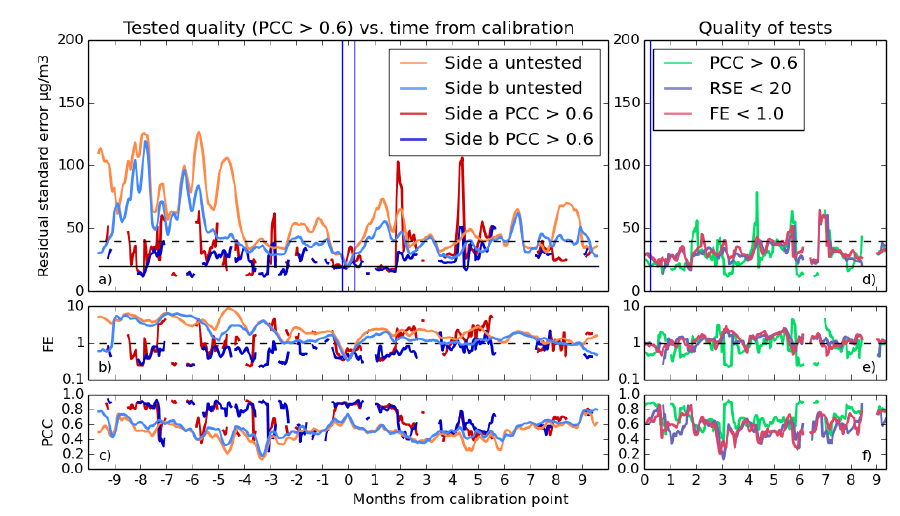
Figure 12. ( a – c ) Comparison between sensor data for NO without goodness testing (light) and with 2 (dark). Both Sensors a and b are plotted. Since fewer fits are used, error due to averaging is higher, and there are both gaps and alarming spikes in the RSE in graph ( a ). However, testing for fractional error improves both FE and correlation. ( d – f ) shows the effect using various tests has on the statistics of the data, averaging the absolute time from calibration and over both sensors.